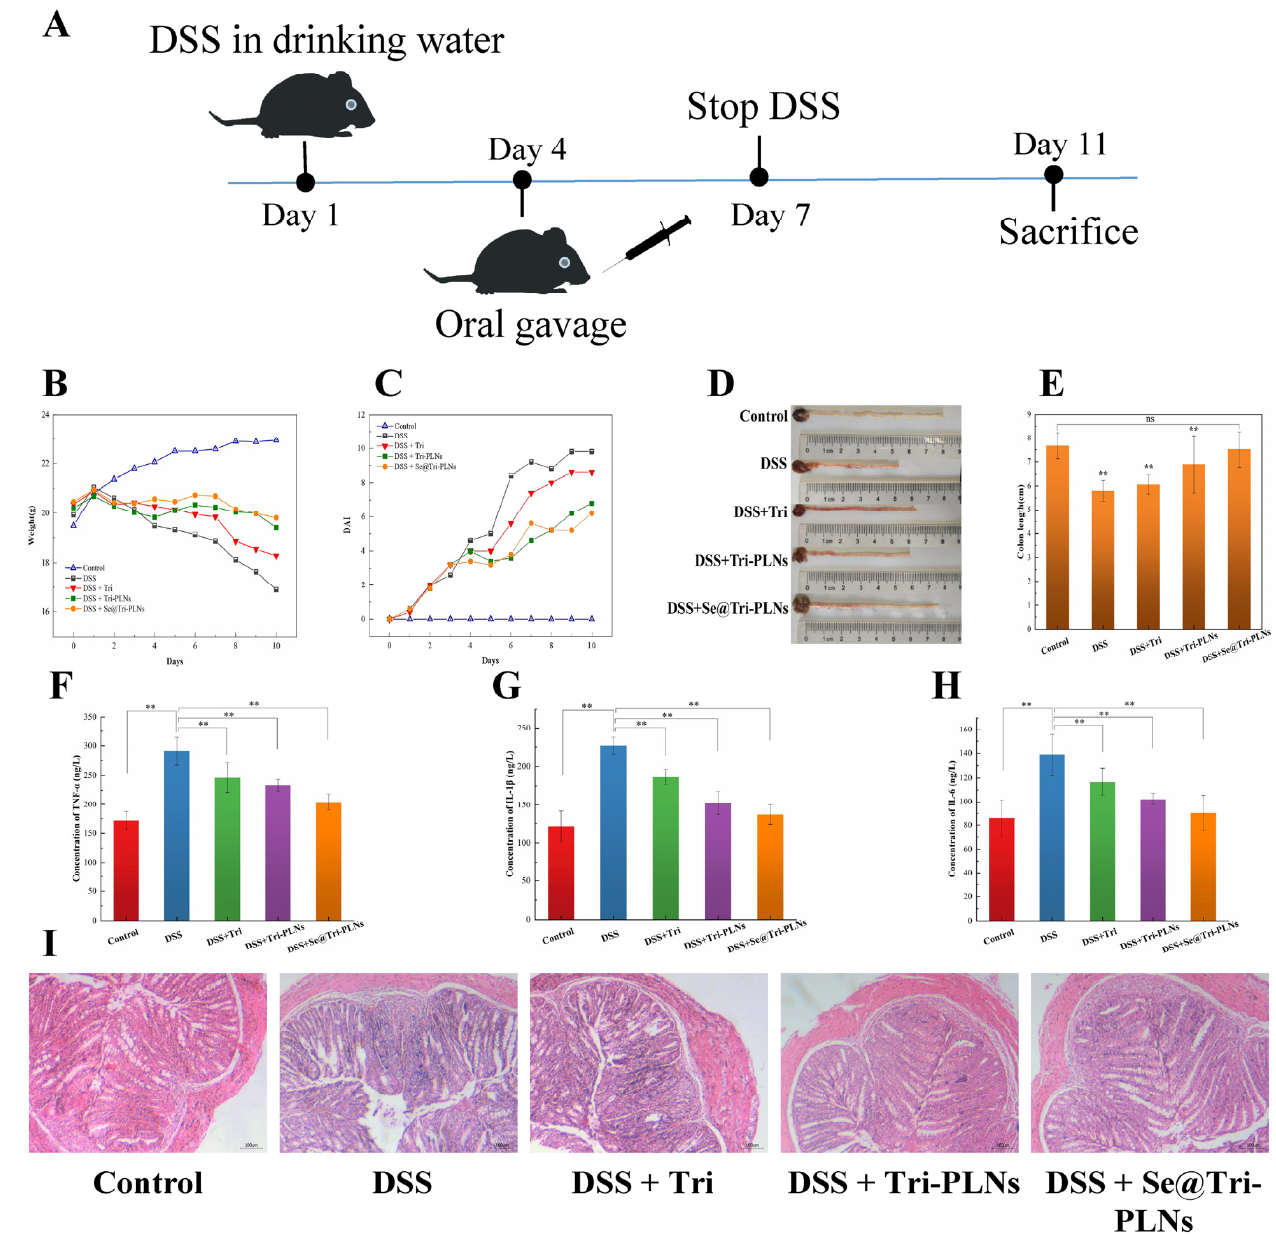
Figure 11. In vivo anti ‐ inflammation evaluation based on a DSS ‐ induced murine ulcerative colitis model: ( A ) schematic diagram of modeling and treatment; ( B ) changes in body weight; ( C ) DAI index; ( D ) colon imaging; ( E ) colon length; ( F – H ) serumal levels of TNF ‐α , IL ‐ 1 β and IL ‐ 6; and ( I )